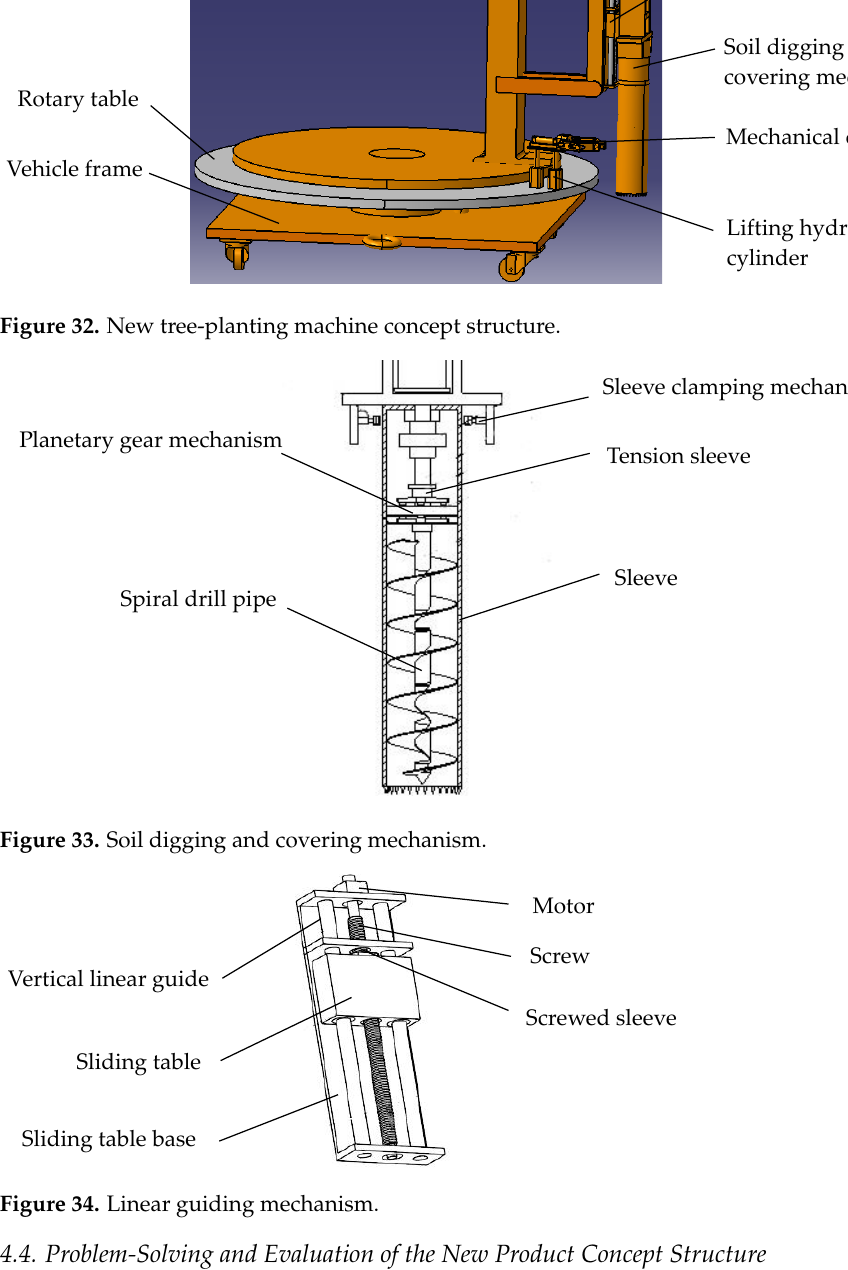
Figure 34. Linear guide mechanism.